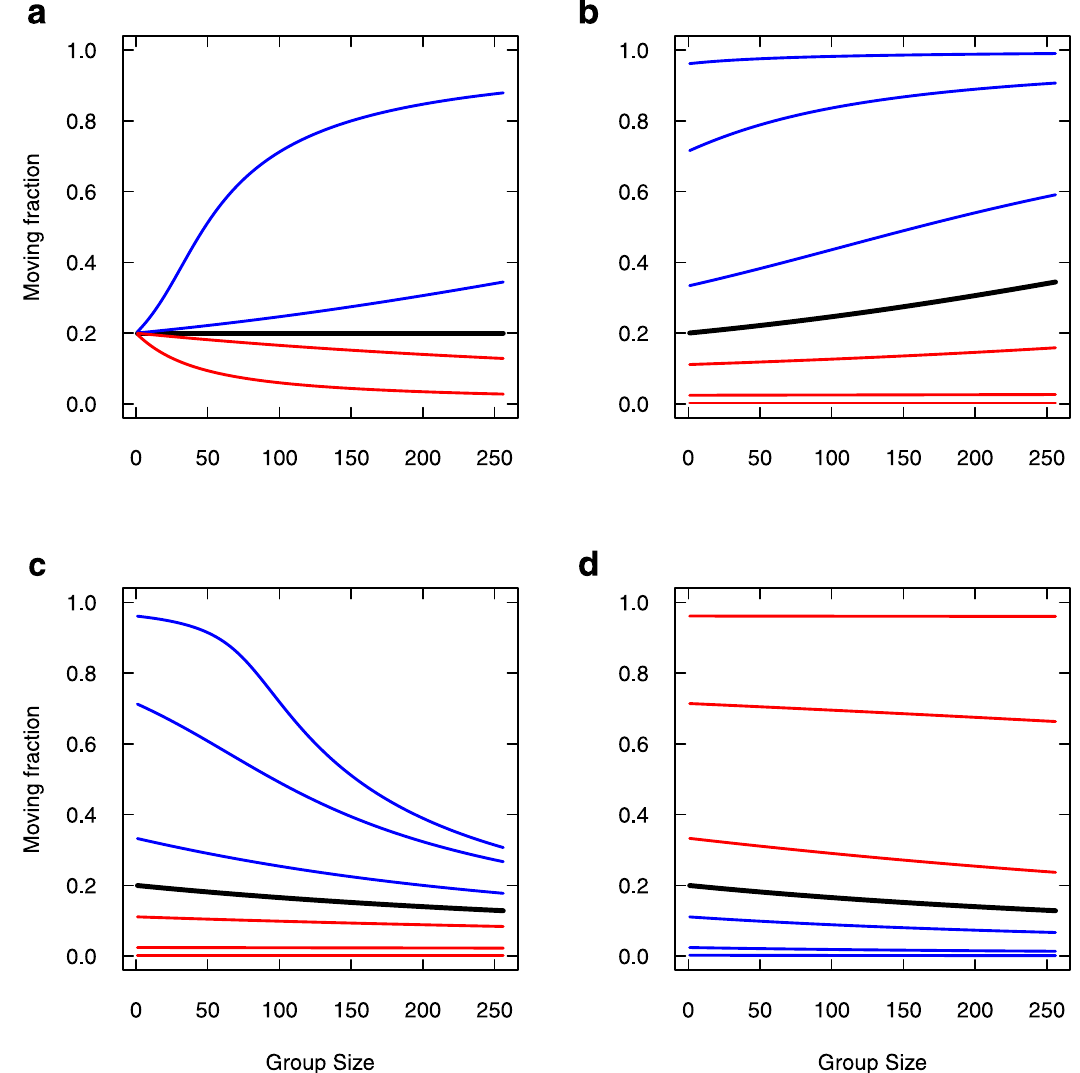
Fig 7. Moving fraction as a function of group size, varying individual parameters. (a) The symmetrical imitations case is reported in black, with α A = α I = α = 0.5, m � ¼ 0 : 02 and m � ¼ 0 : 08 . Blue curves: α A = 1.001 α and α A = 1.01 α keeping α I = α , and red curves: A I keeping α = α . (b) Setting α = 1.001 α , μ is varied from lower (blue) to higher (red) values than m � same variations for α I A A I Variations correspond respectively to division or multiplication by 2, 10 and 100. (c) Setting α I = 1.001 α , μ I is similarly varied from lower (blue) to higher (red) values than m � (black). (d) Setting α = 1.001 α , μ is similarly varied from lower (blue) to higher (red) I A I values than m � A